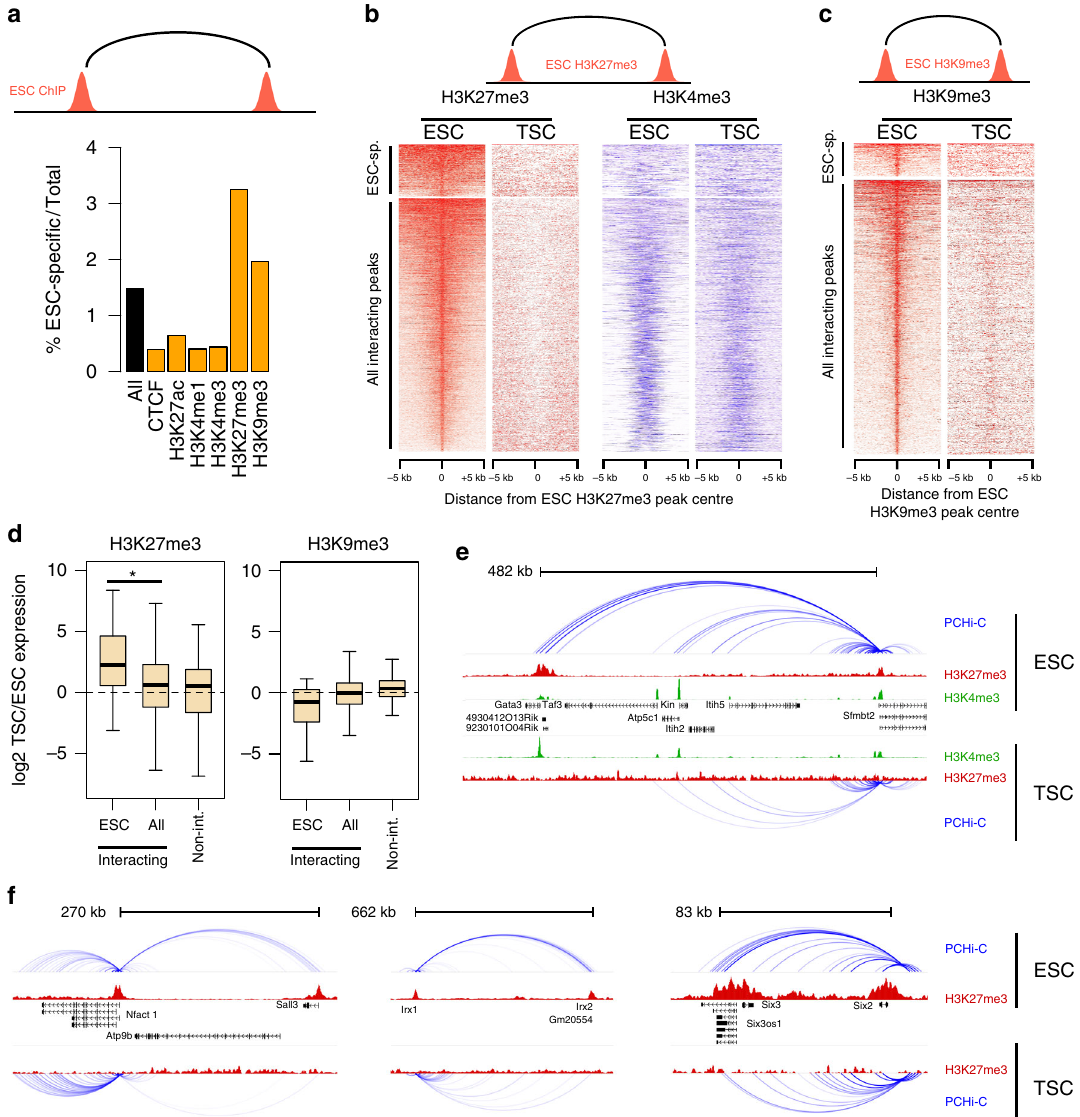
Fig. 2 H3K27me3 interactions in ESCs involve TSC-speci fi c genes. a Percentage of ESC-speci fi c interactions among all interactions (black bar) or homotypic interactions involving the proteins/modi fi cations indicated (orange bars). b H3K27me3 and H3K4me3 ChIP-seq signals centred on the peaks involved in ESC H3K27me3 homotypic interactions. Top heatmaps are for ESC-speci fi c interactions only. c H3K9me3 ChIP-seq signals centred on the peaks involved in ESC H3K9me3 homotypic interactions. d Expression ratio (log2) between TSC and ESCs for genes involved in either H3K27me3 or H3K9me3 homotypic interactions (all or ESC-speci fi c), and compared with genes not involved in homotypic interactions. Boxplot midline represents median, box edges the fi rst and third quartiles, and whisker edges are the last data points within 1.5× the interquartile range. * p < 0.05 ( t -test). e , f Examples of H3K27me3 homotypic interactions in ESCs involving TSC-expressed